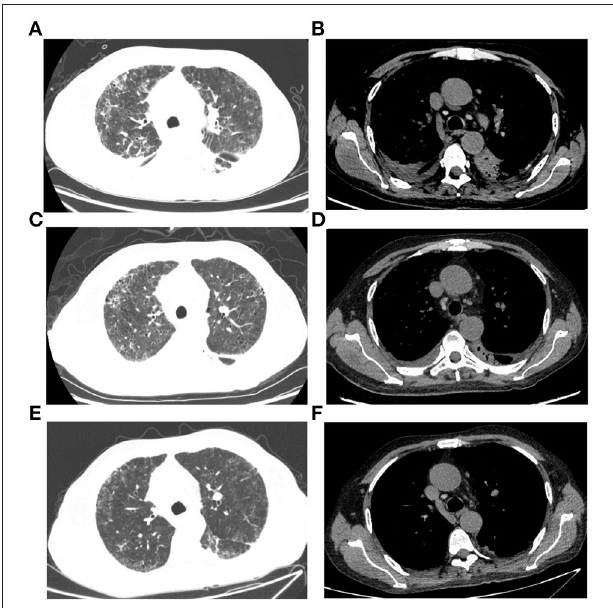
FIGURE 1 | Chest CT imaging of the patient. (A,B) CT imaging on October 22, 2020; (C,D) CT imaging on November 3, 2020; (E,F) CT imaging